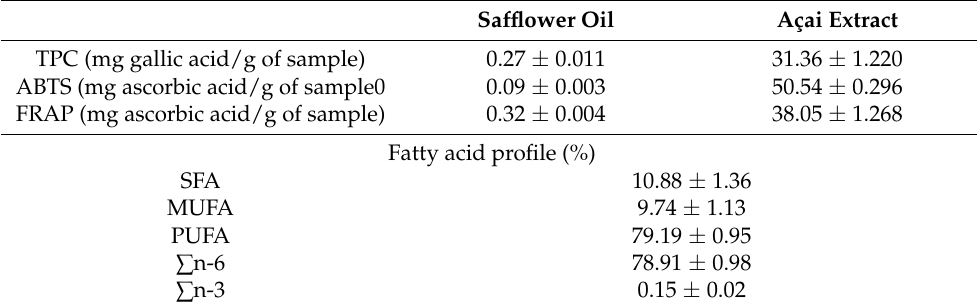
Table 3. Characteristics of açai extract and safflower oil.